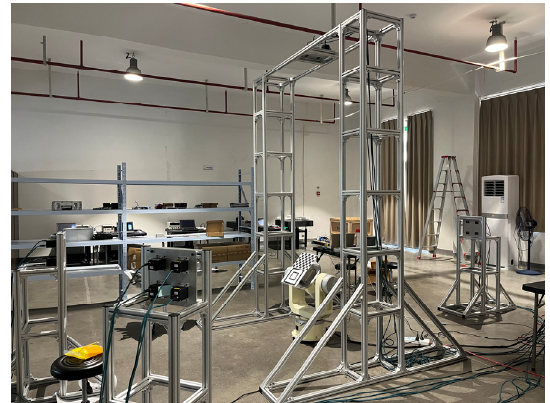
Figure 5. Depth camera calibration scenario.